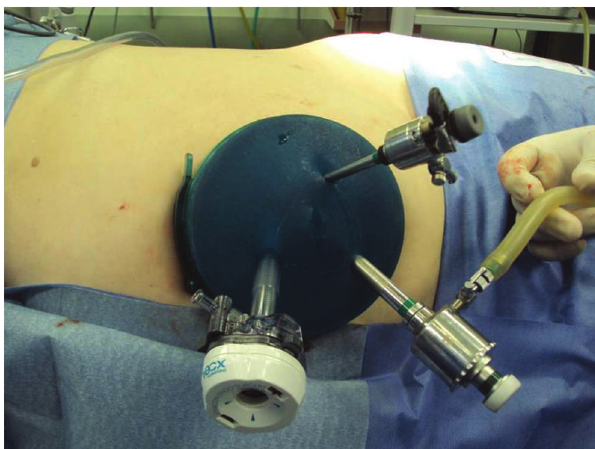
Figure 1 - Single-site access with the Gelport and triangulation of the Trocars.